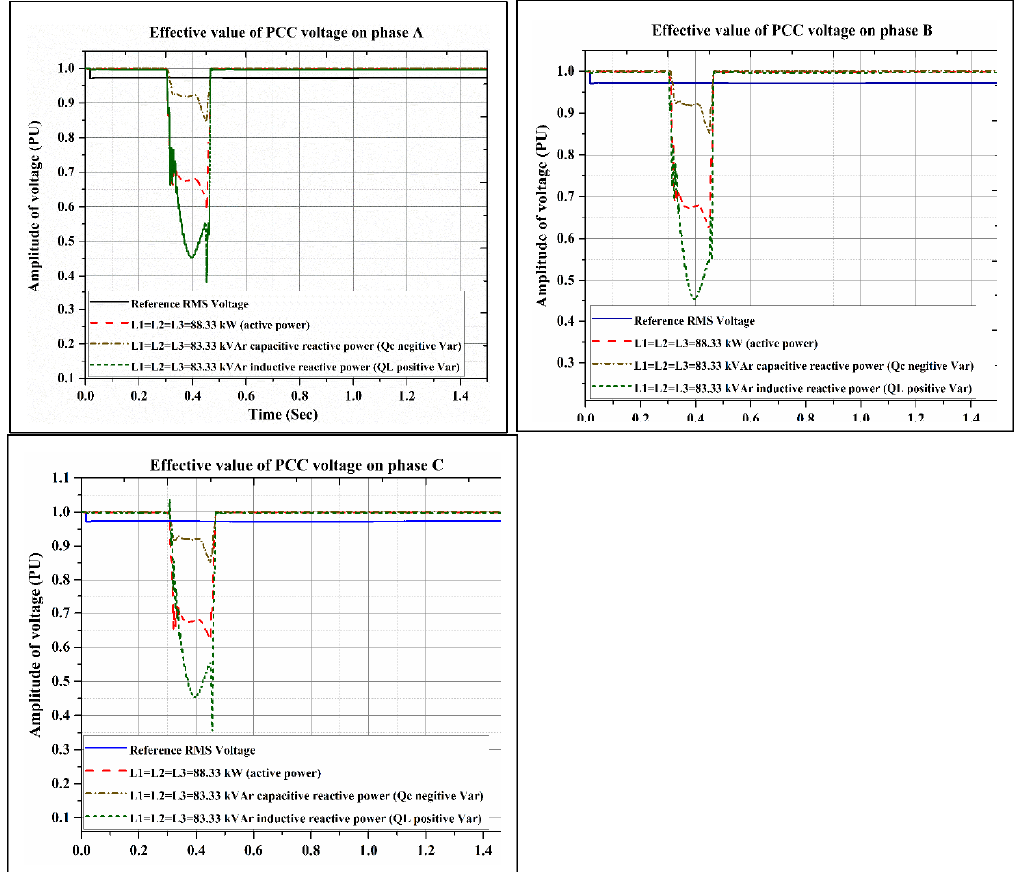
Figure 9. The effective value of PCC voltage when local loads match with local Figure 9 . The effective value of PCC voltage when local loads match with local generation.